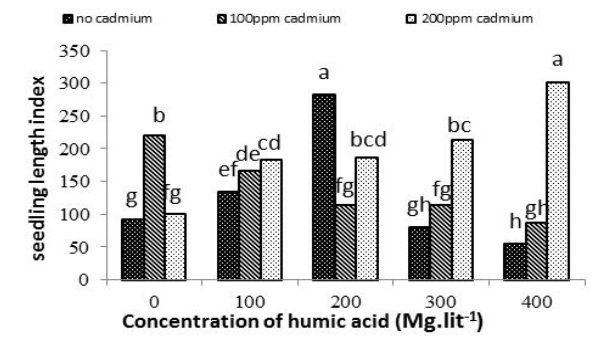
Fig. 8. Effect of humic acid and cadmium concentration on the cotyledon dry weight of pumpkin seeds